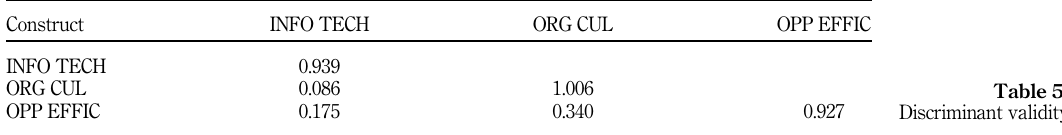
Table 4. Comparison of